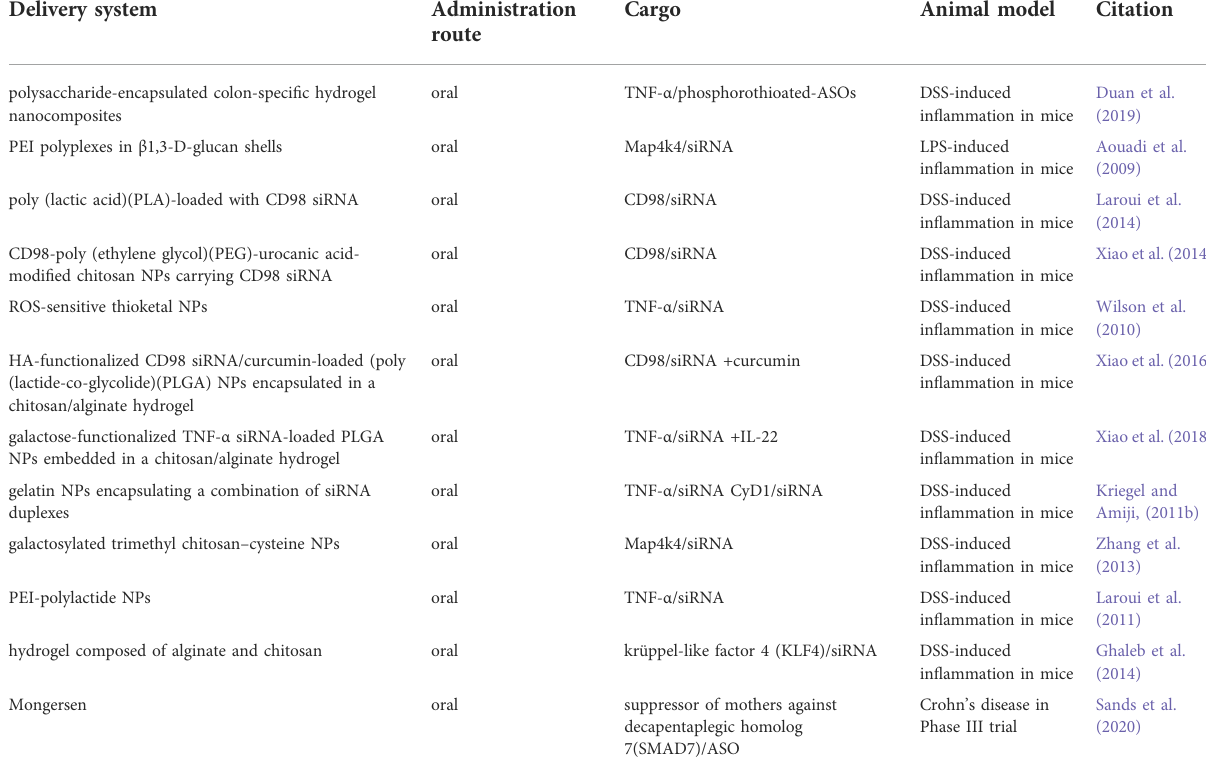
TABLE 2 Animal models and clinical trials of nucleic acid-based gene therapeutics for